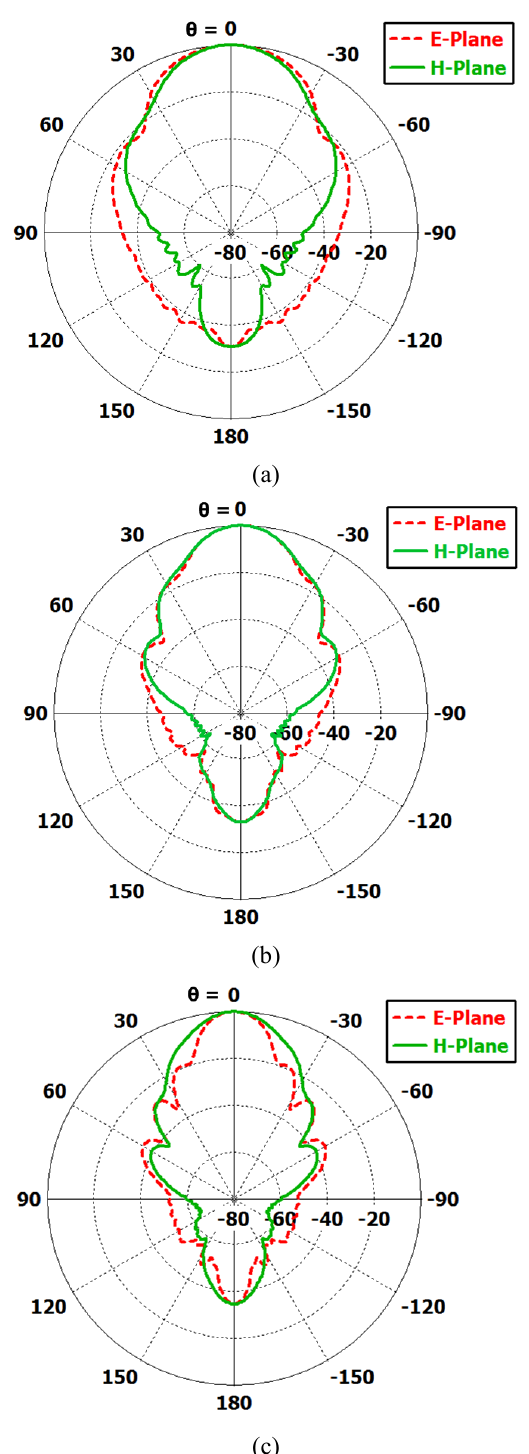
Figure 5: The simulated co-polarization normalized patterns (E-plane and H-plane) of the designed antenna with PLA/nickel for (a) 10.5 GHz (b) 14.5 GHz (c) 18.5 GHz. The cross polarization performance of the antenna with PLA/nickel is also satisfactory that unnormalized cross- polarization gain values are found be at most -55 dBi over the full H-plane and E-plane ( ϕ = 0° and 90° cuts) within the frequency band. When co-polarization gain values